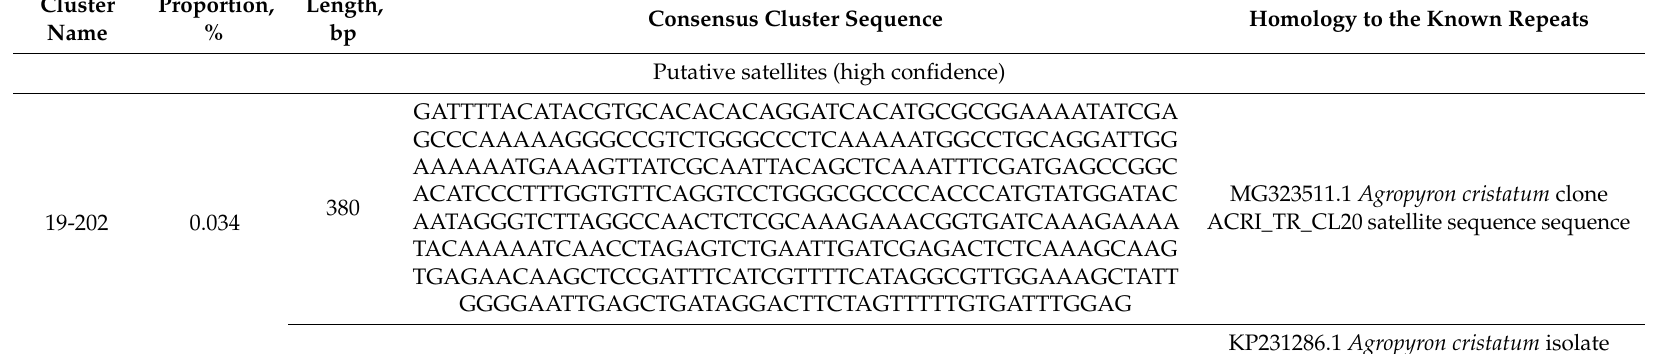
Table 1. Characterization of selected satellite clusters, based on amount of copy, identification by RepeatExplorer2 as satellite with high probability and weak homology to known wheat